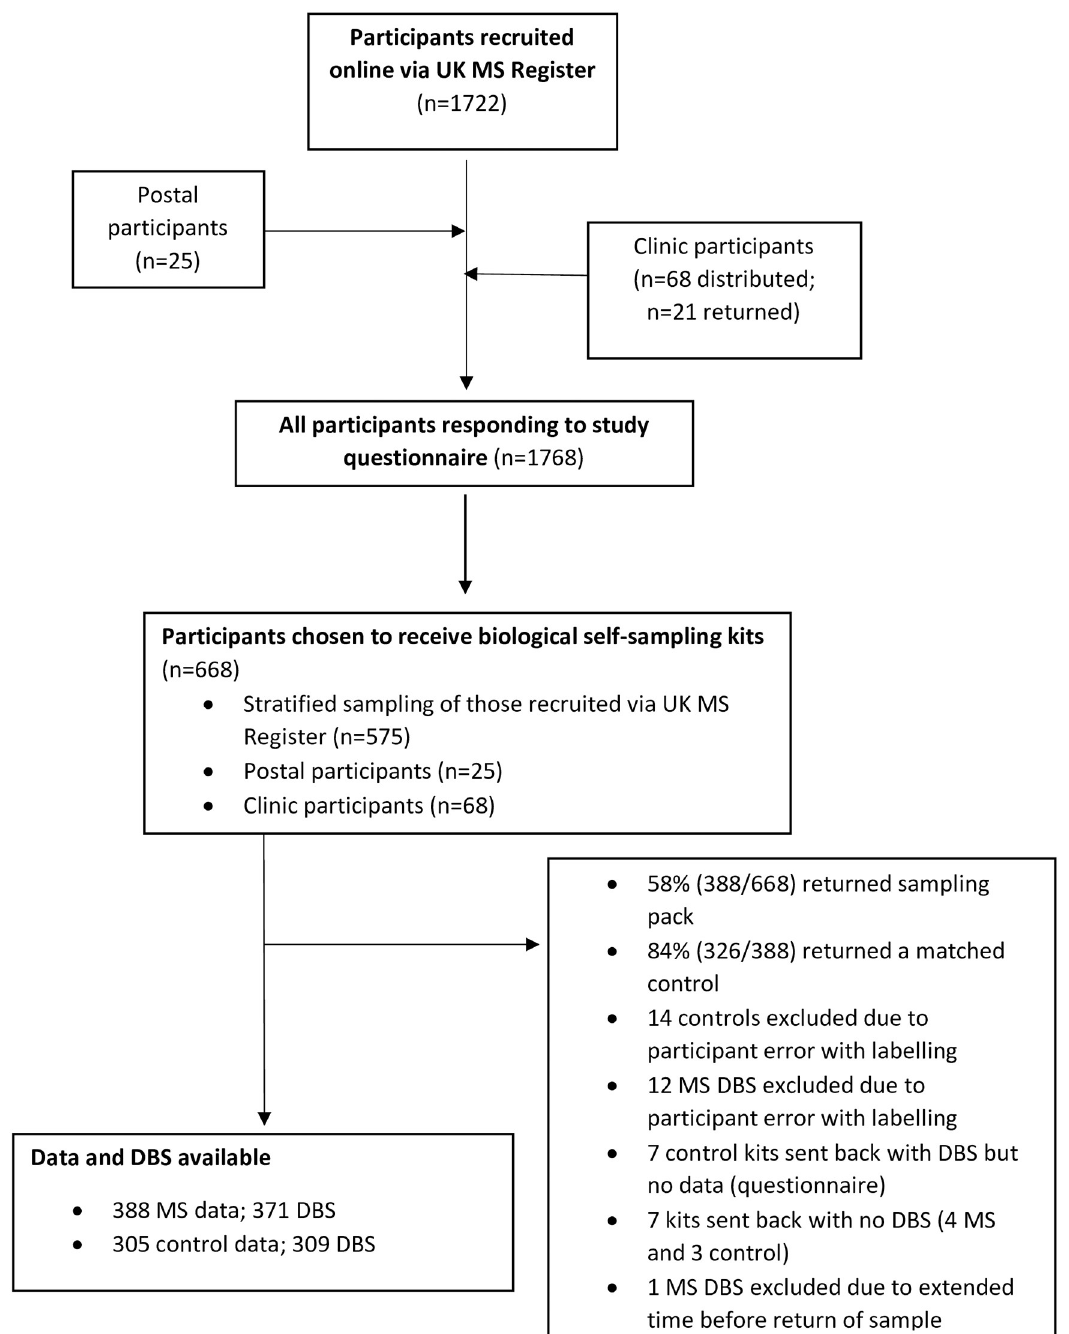
Fig 1. Flow chart of the study recruitment and resulting study population. 388 MS participants and 309 matched controls returned sampling kits. In some cases, data or biological material was not available for all data points, resulting in 388 MS with data and 371 MS with DBS and 305 controls with data and 309 controls with